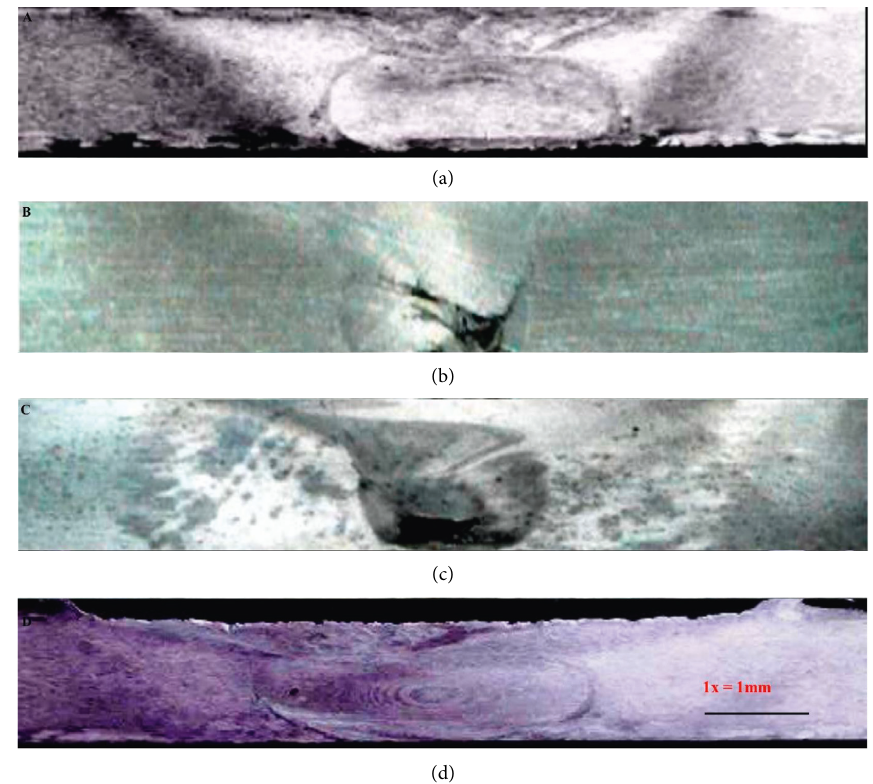
Figure 6: Macroscopic view of (a) weld at 0 ° tool angle, (b) weld at 1.5 ° tool angle, (c) weld with tunnel, and (d) distinct weld zones.